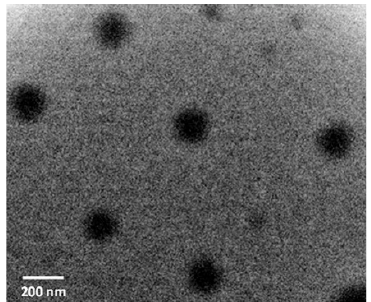
Figure 3. Hollow p(VP-AA) TEM micrograph showing their size and morphology. The images confirm the spherical shape of the NPs. Scale bar: 200 nm.